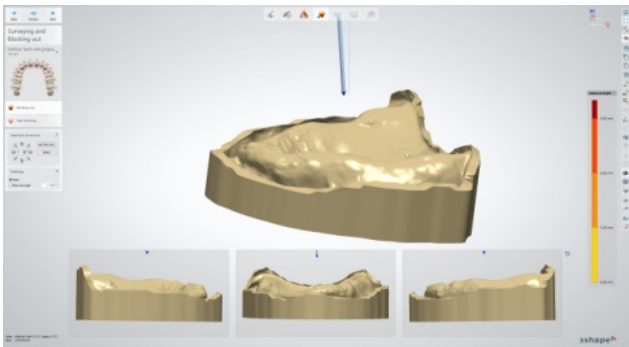
Figure 9. Reference points (canines, incisive papilla and maxillary tuberosity) are marked digitally and serve as guidelines for tooth set-up.